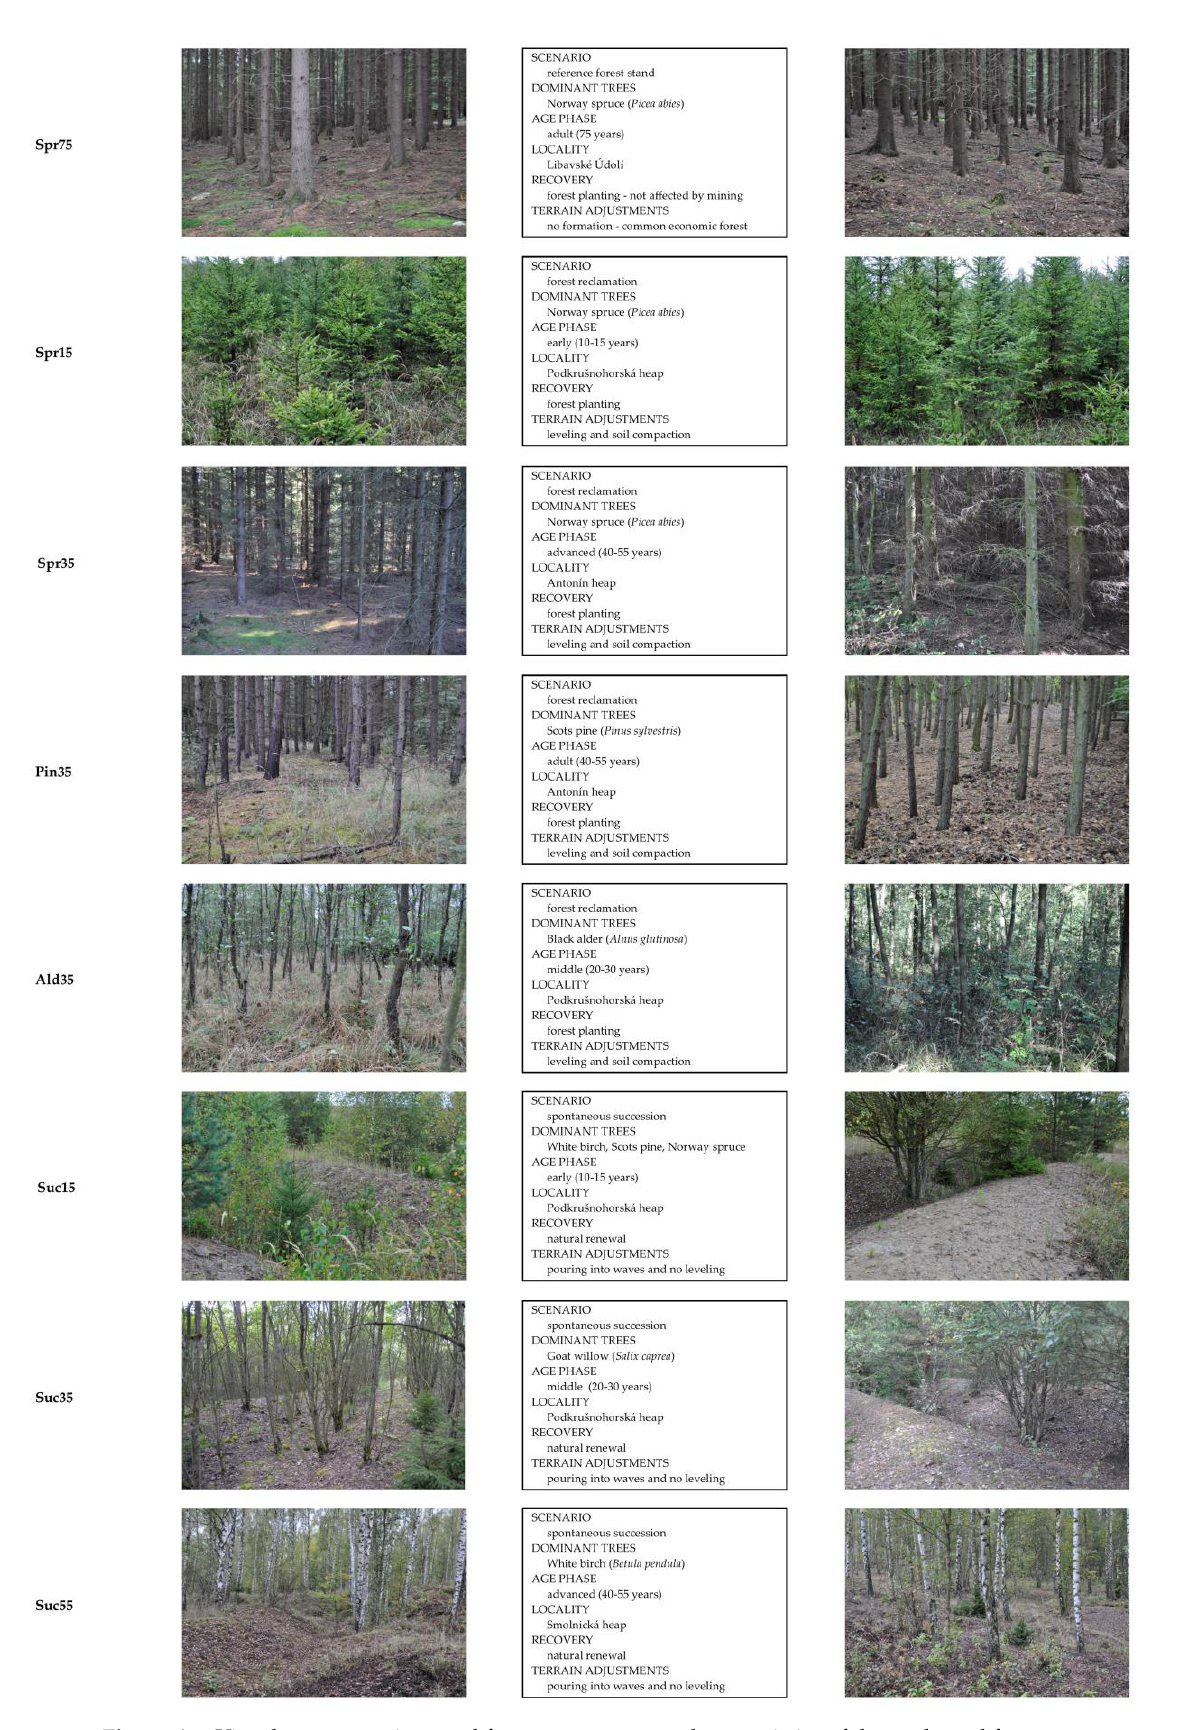
Figure A1. Visual representations and forest management characteristics of the evaluated